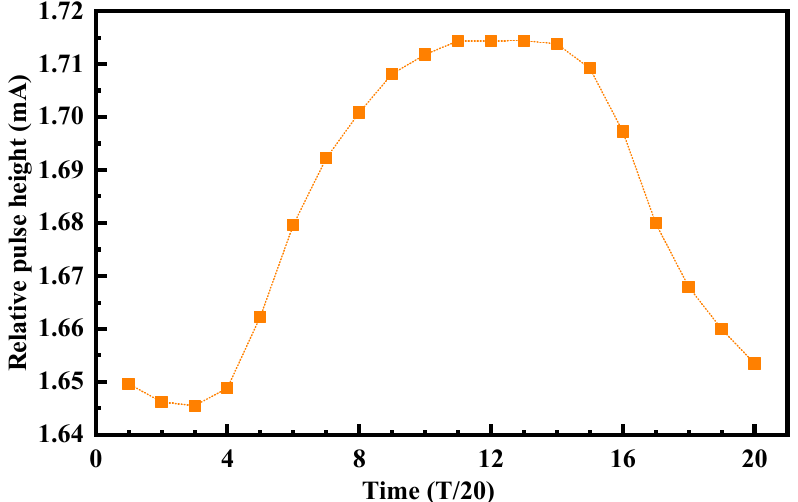
Figure 6. Simulation results of current pulse height of different bombardment times.